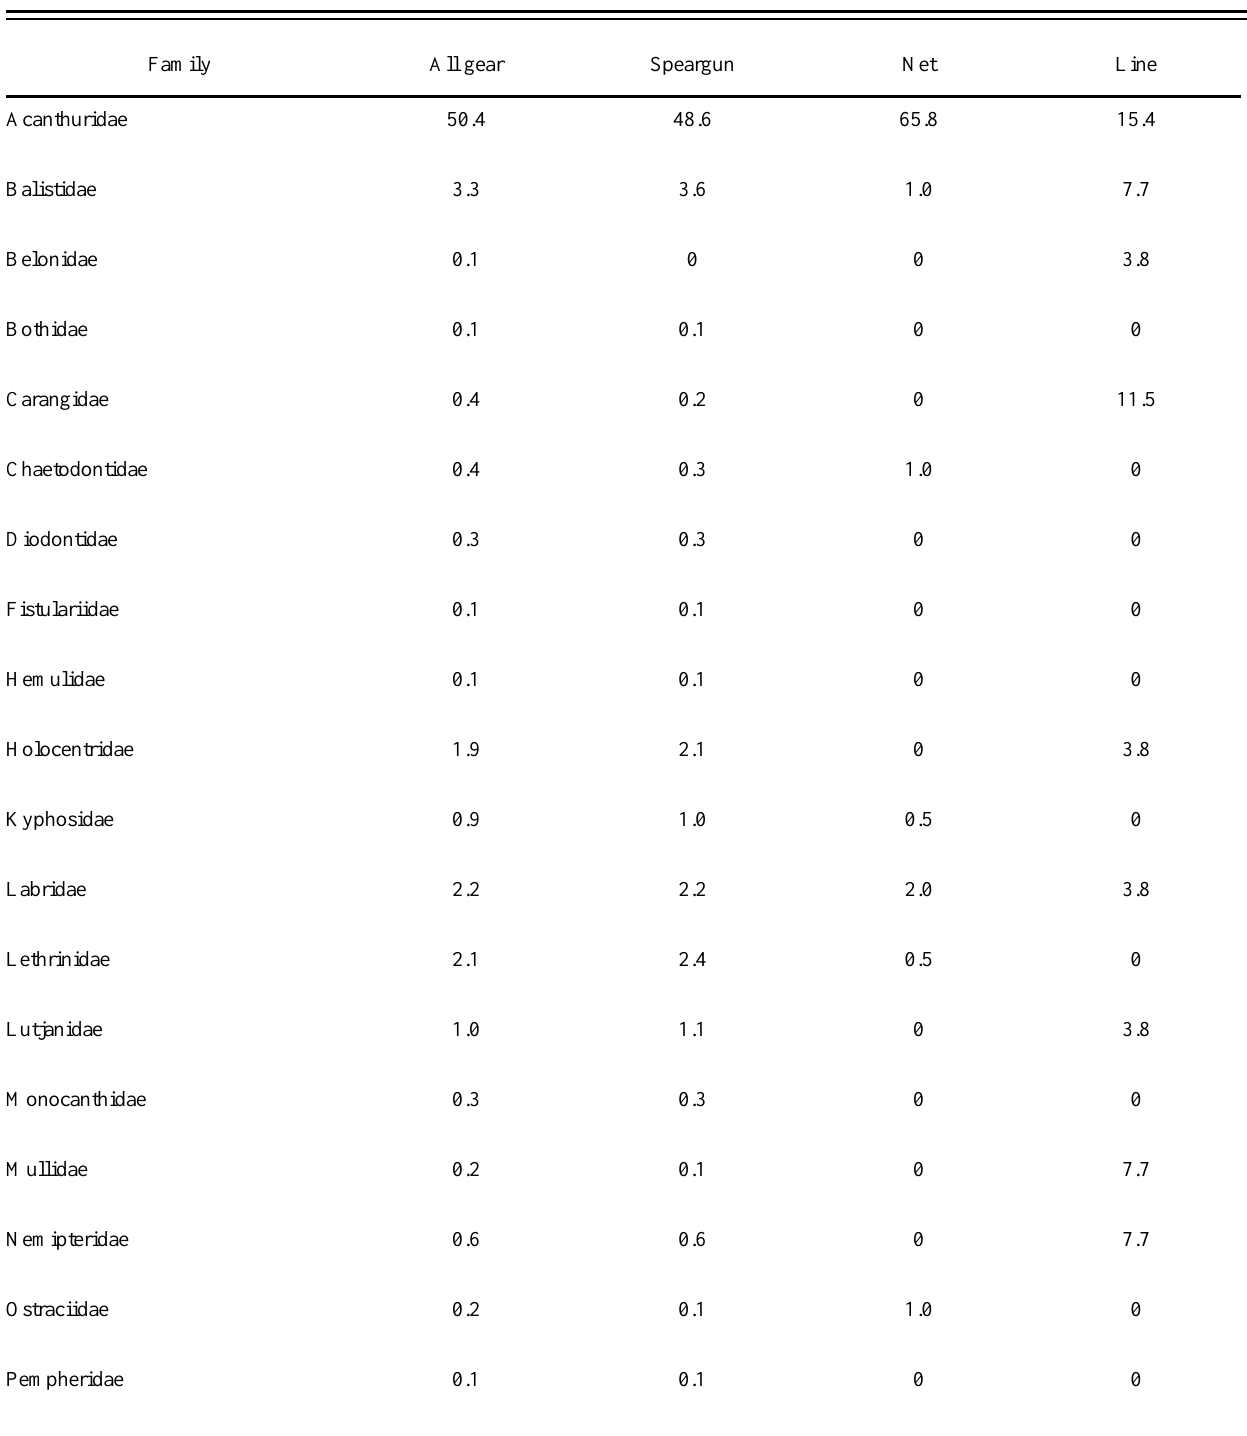
Table 4. Fish families caught in Kakarotan fishing